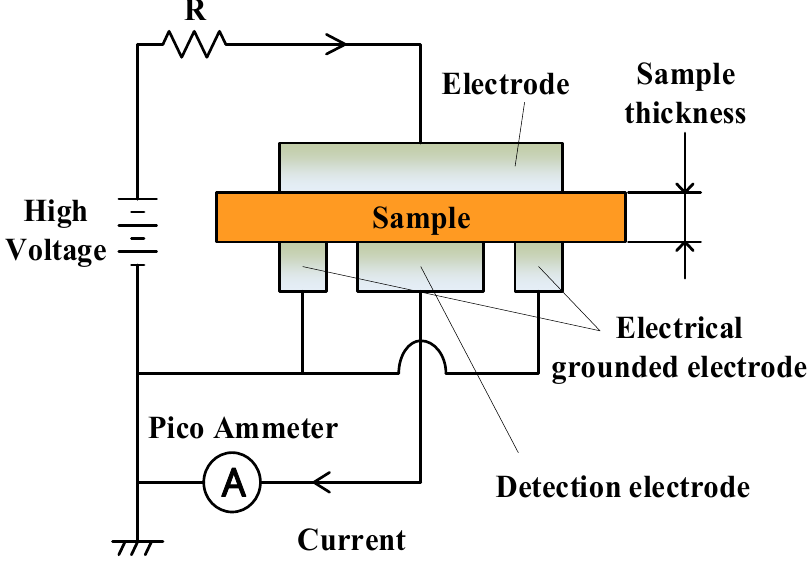
Figure 2. A principle of the ASTM method.